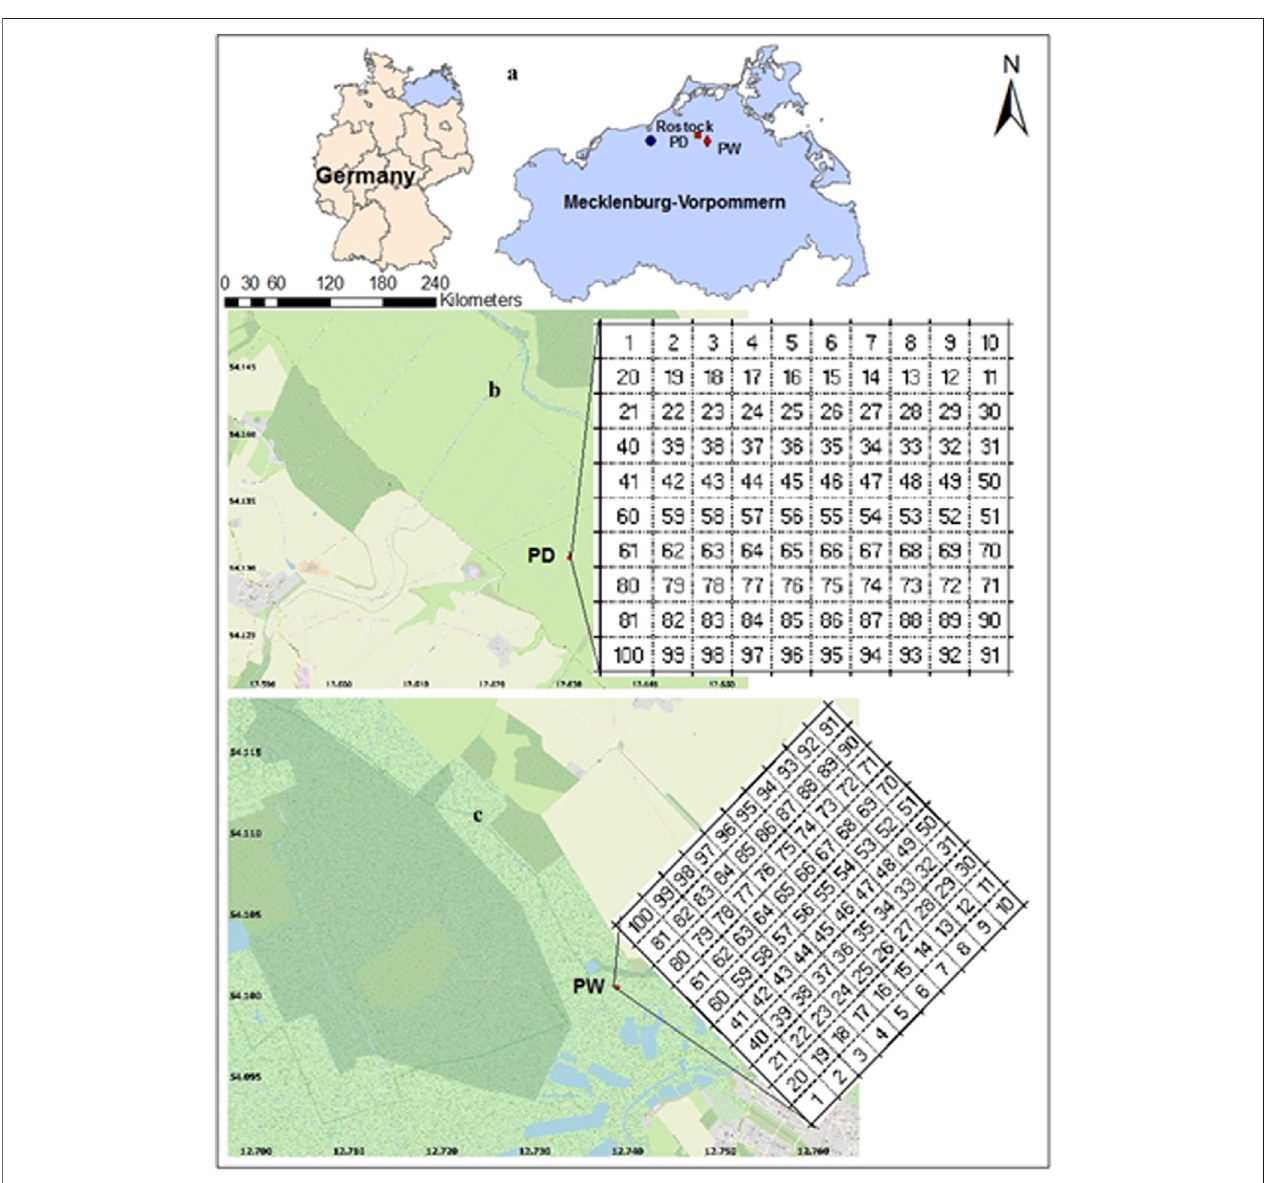
FIGURE 1 | Geographical location of the study sites and spatial soil sampling